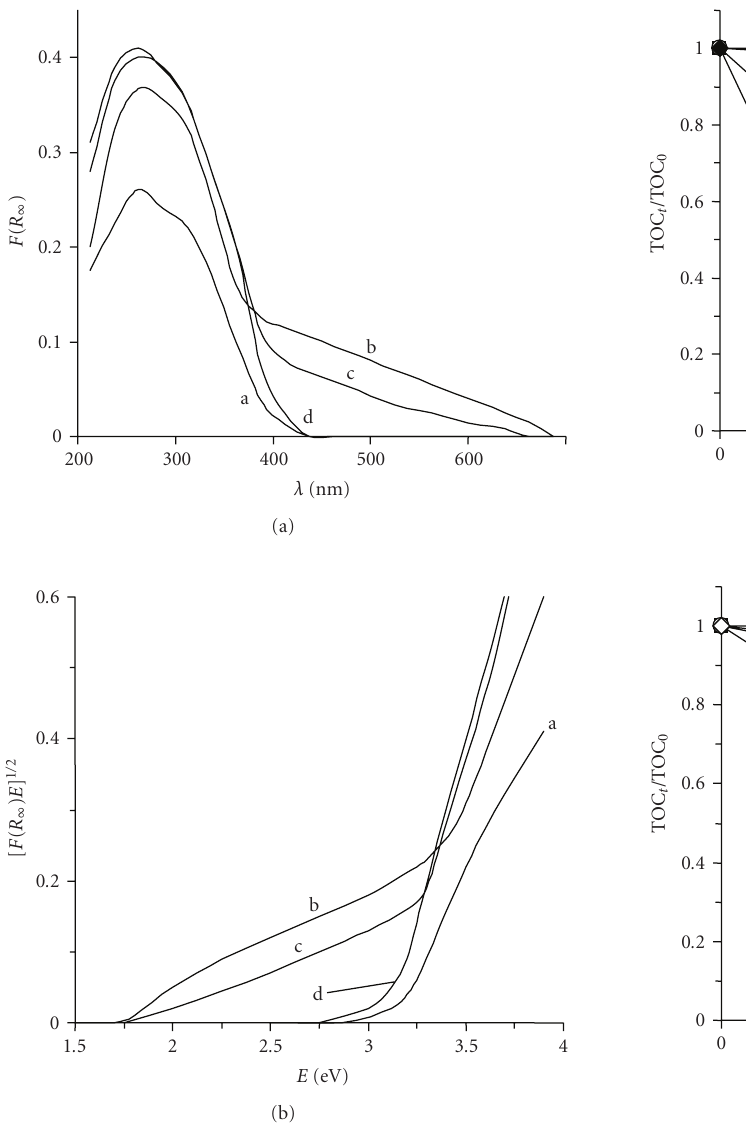
Figure 2: (A) Photomineralisation of 4-chlorophenol with artificial visible light ( λ = 455 nm; TOC 0 and TOC t = total organic carbon content at times 0 and t); (B) di ff use indoor daylight degradation of 4-chlorophenol and remazol red on pure and modified TiO 2 ; (a) TiO 2 , (b) TiO 2 -2.98%C, (c) TiO 2 -0.42%C, (d) TiO 2